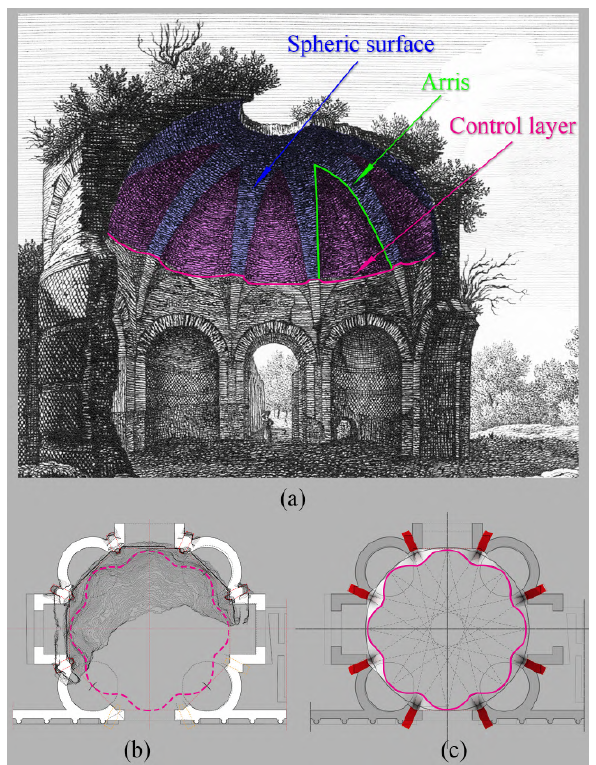
Figure 14. (a) State of conservation of the Vestibule as documented by Penna (1836). (b) Contour lines: in evidence remaining control elements of the construction. (c) Idealized shape achieved through subdivision surfaces.